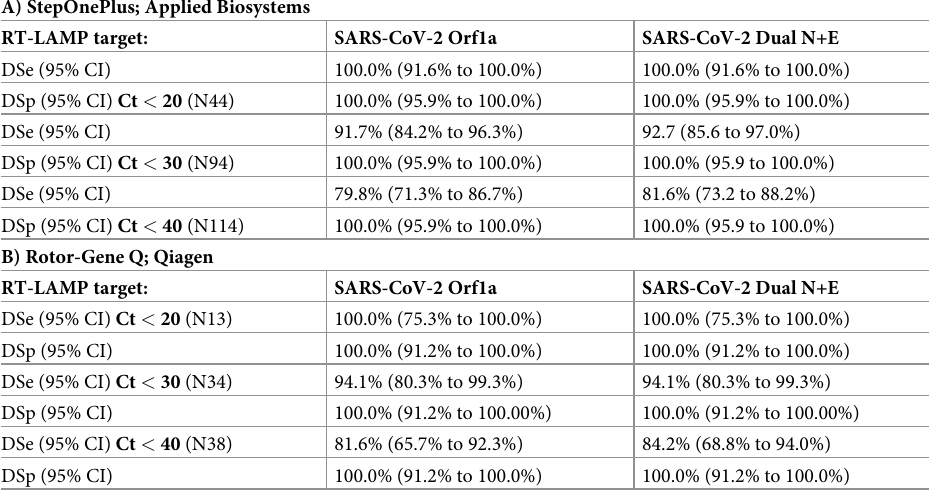
Screening was performed to ISO 15189:2012 standards, guided by the Leicester Molecular Diagnostic Lab. RNA extracted from throat and lower nasal cavity swabs from 1,673 symptom free individuals attending campus (autumn 2020) were processed through RT-LAMP targeting the Orf1a and internal control ACTB. The RT-LAMP assay was run for 20 minutes, detecting equivalent to a Ct < 30 (S4 Table). During this period, a single repeat swab was requested due to inefficient sampling as identified by failure of amplification within the ACTB control reac- tion indicating absence of total RNA. In total, 9 RT-PCR confirmed RT-LAMP positive results from a total of 1,673 tests demonstrated a prevalence of asymptomatic infection of 0.54% (540 Table 3. DSe and DSp of single genomic versus dual sub-genomic SARS-CoV-2 fluorescent end-point RT-LAMP assays performed using residual RNA extracted from clinical patient ON swab samples with comparator RT-PCR Ct values. Assays were run at 65˚C for 40 minutes on A) StepOnePlus PCR platform (114 UHL positive samples & 88 UHL negative samples) and B) Rotor-Gene Q Qiagen PCR platform (38 UHL positive samples & 40 UHL negative samples). Sensitivity and specificity with 95% CI are shown for samples with a corresponding RT-PCR Ct < 20, Ct < 30 and Ct < 40. Calculations performed using the MedCalc Scientific